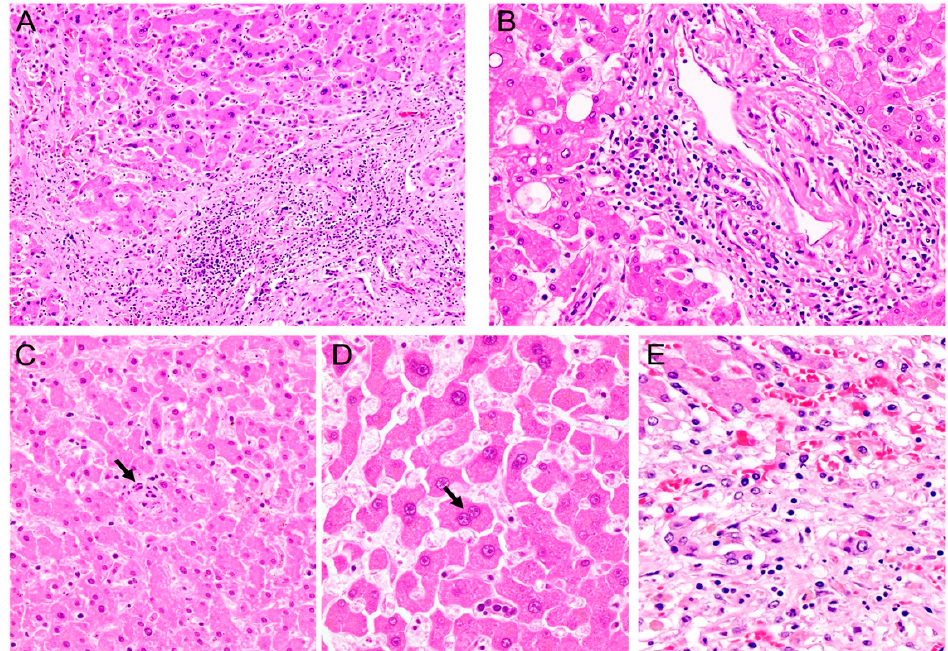
Figure 2. Liver damage after SARS-CoV-2 infection. Severe chronic portal inflammation is observed in livers of patients with acute COVID-19 (Panels ( A , B ), Hematoxylin and Eosin, original magnification 200 × and 400 × , respectively). At higher magnification the fragmented nuclei of apoptotic hepatocytes are present (Panel ( C ), arrow), as well as Binucleation of hepatocytes (Panel ( D ), arrow). In severe cases, extensive areas of necrosis were observed (Panel ( E )) Panels ( C – E ), Hematoxylin & Eosin, original magnification 400 ×